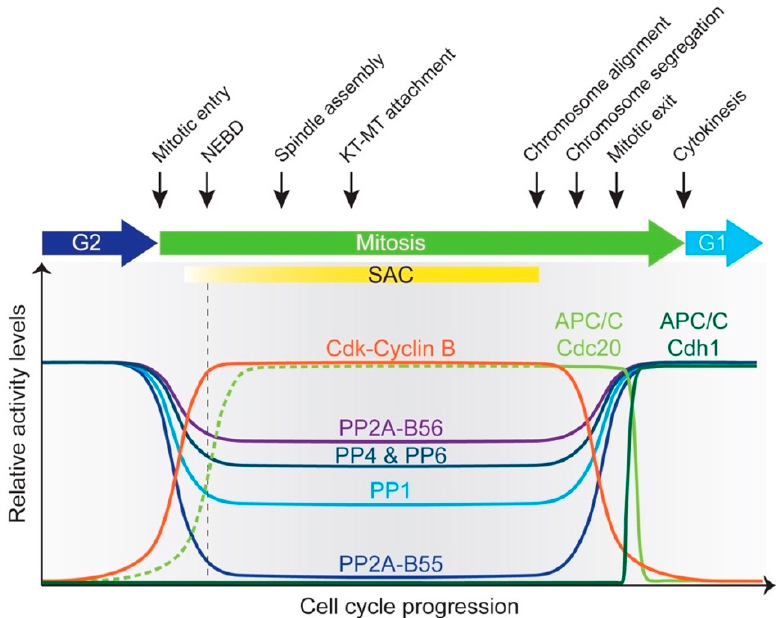
Figure 3. Activity dynamics of cell cycle phosphatases and the APC / C throughout mitosis. Only major serine / threonine phosphatases are depicted. Precise activity dynamics of PP2A-B56, PP4 and PP6 are not well understood in the context of other cell cycle events. During early mitosis, the APC / C-Cdc20 activity (dotted light green line) is held in check by the spindle assembly checkpoint (SAC; yellow bar) until correct bipolar attachment of chromosomes to the mitotic spindle is achieved. Only substrates that can directly bind the APC / C (such as Cyclin A and Nek2A) are degraded at this stage. Once the SAC is silenced, the APC / C-Cdc20 becomes fully active (solid light green line) and ubiquitylates substrates such as securin and Cyclin B for degradation. Most cell cycle phosphatases are under regulatory control of Cdk1, albeit with di ff erent mechanisms, in order to avoid futile phosphorylation events in mitosis. See text for details. Abbreviations: KT-MT, kinetochore-microtubule; NEBD: nuclear envelope breakdown.